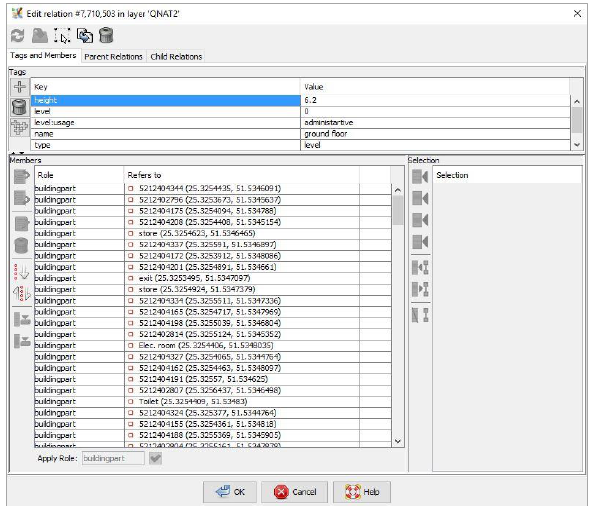
Figure 8. Building and individual level